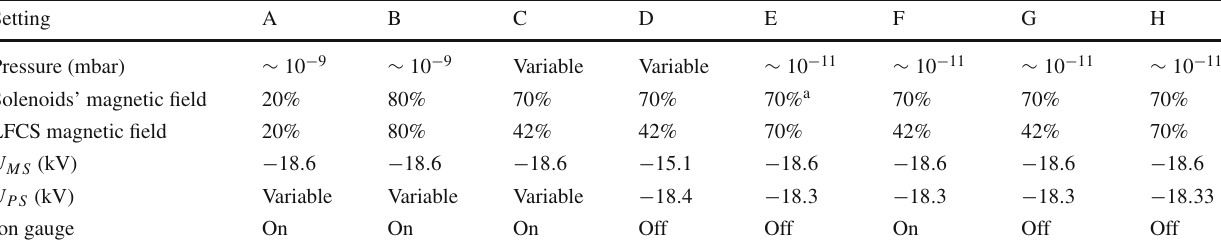
Table 1 Settings for measurements before (A, B) and after (C–H) the bake-out of the spectrometers Setting